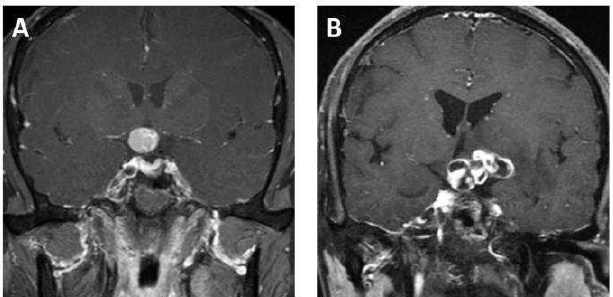
Figure 2. Representative contrast-enhanced T1-weighted MR images of ( A ) adamantinomatous craniopharyngioma and ( B ) papillary craniopharyngioma.